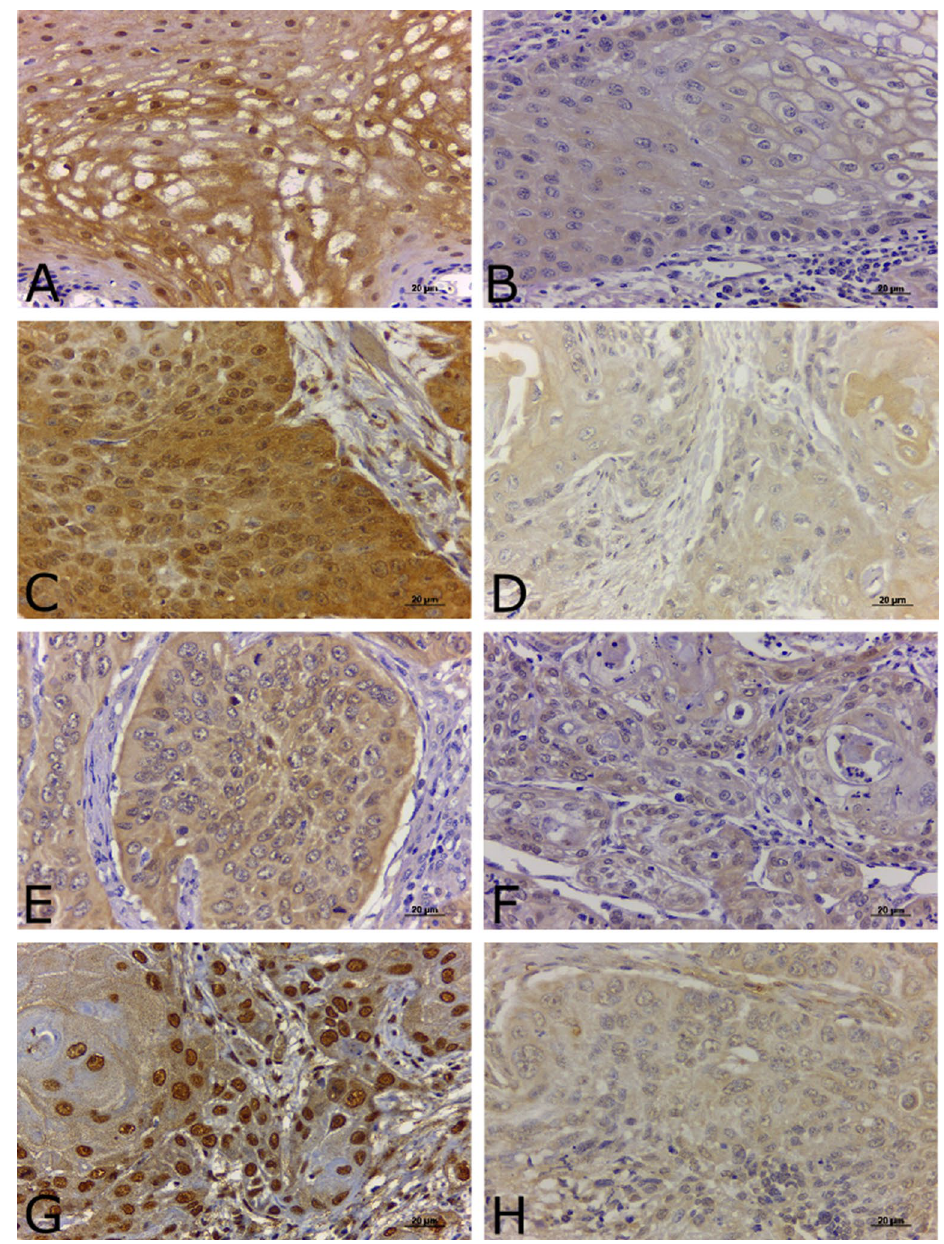
Figure 1. Imunnohistochemistry photomicrographs. ( A ) Strong intensity cytoplasmic and nuclear immunostaining of SOD-1. ( B ) Low intensity cytoplasmic immunostaining of SOD-1. ( C ) Strong intensity cytoplasmic and nuclear immunostaining of OGG1/2. ( D ) Low intensity cytoplasmic immunostaining of OGG1/2. ( E ) Strong intensity cytoplasmic immunostaining of Trx. ( F ) Low intensity cytoplasmic immunostaining of Trx. ( G ) Strong intensity cytoplasmic and nuclear immunostaining of Ref-1. ( H ) Low intensity cytoplasmic immunostaining of Ref-1. SOD-1 superoxide dismutase, Ref-1 purinic/apyrimidinic endonuclease/redox factor-1, OGG1/2 8-oxoguanine glycosylase. Original magnifications of